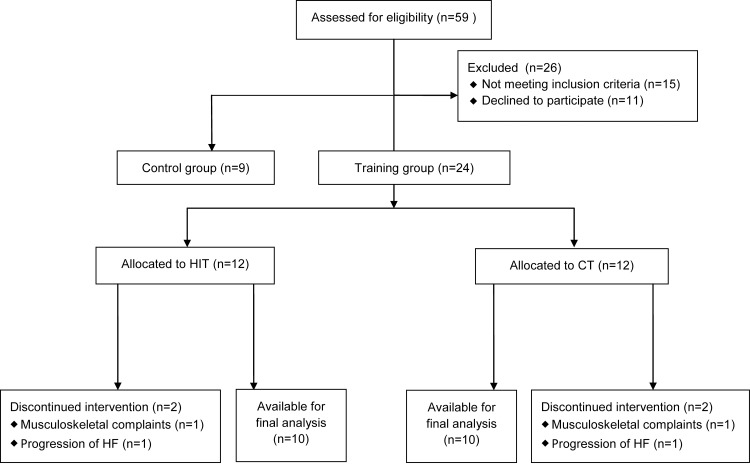
Flow-chart of the inclusion of subjects.